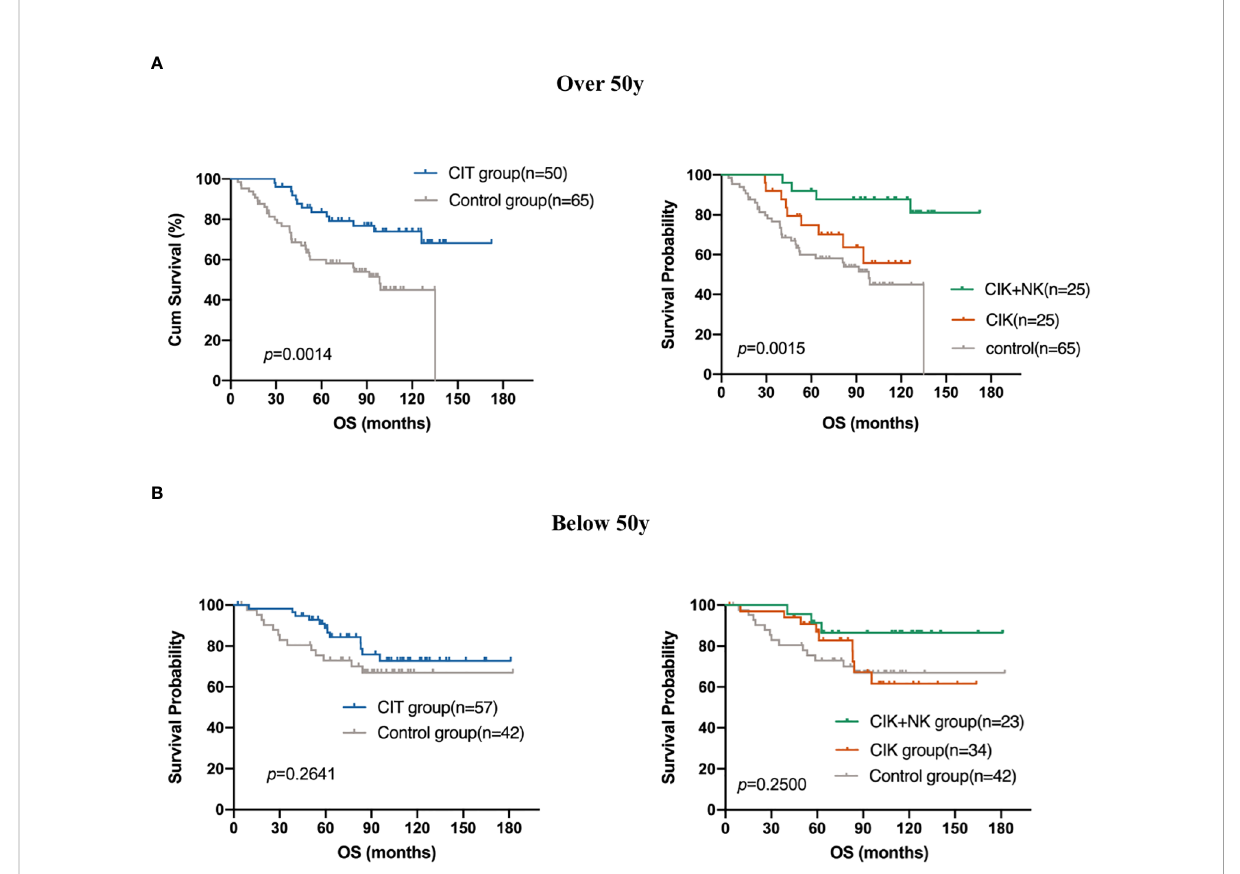
FIGURE 6 Subgroup analysis to estimate the survival bene fi ts from CIT in patients who are (A) over 50 years old (n=115) and who are (B) below 50 years old